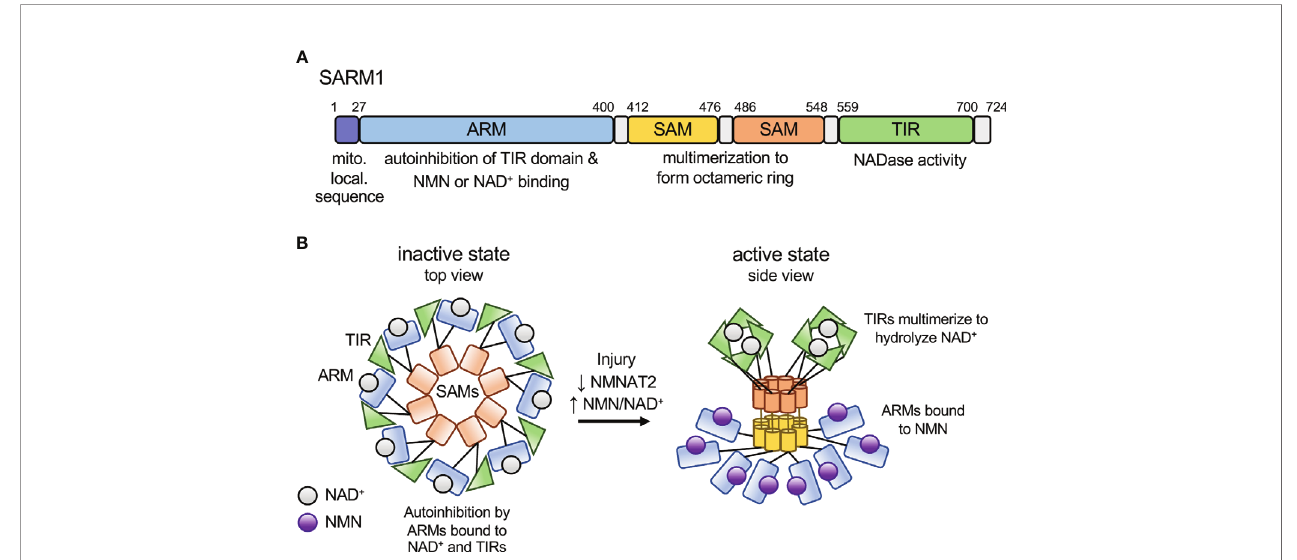
FIGURE 1 | Model of SARM1 domain structure and activation mechanism. (A) Domain structure of the human SARM1 protein. SARM1 contains an N-terminal mitochondrial localization sequence and Armadillo-repeat containing domain (ARM), two tandem sterile alpha motif (SAM) domains, and a C-terminal Toll/interleukin-1 receptor (TIR) domain. Numbers denote the amino acid position of the domain boundaries. (B) Schematic depicting the activation mechanism of SARM1. In the inactive state SARM1 ’ s ARM domains are bound to NAD + at the allosteric site and bound to adjacent TIR domains both intra- and inter-molecularly, mediating autoinhibition of the TIR ’ s NADase activity. In response to an increase in the NMN/NAD + ratio, NMN binds to the ARM domain allosteric site, resulting in a conformational change in the ARM domain, disengagement of the ARM-TIR interactions, multimerization of the TIR domains and NADase activity. Based on recent structural data from the RPP1 TIR domain, we depict active TIRs as a tetramer forming two active sites for NAD + binding